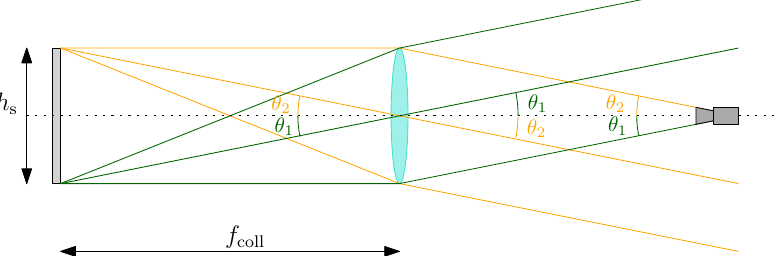
Figure 2. Optical configuration of the components of the TinyV3RSE facility. Note that θ 1 = θ 2 = θ Note that because of the collimation, the distance between the camera and the colli- mating lens d cam is not a design parameter that depends on the collimator focal